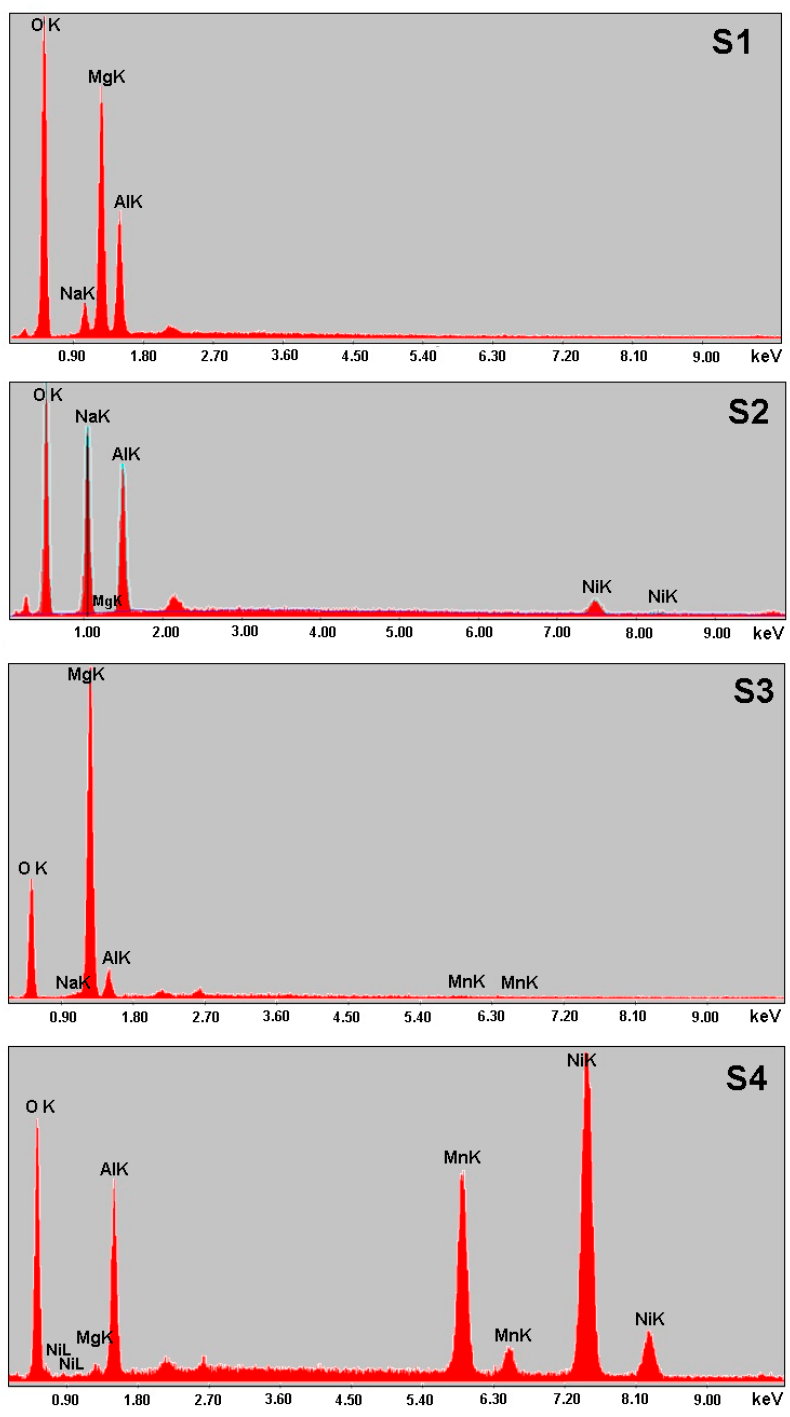
Figure 5. EDX surface analysis of the LDHs, before and after the Mn 2+ adsorption.